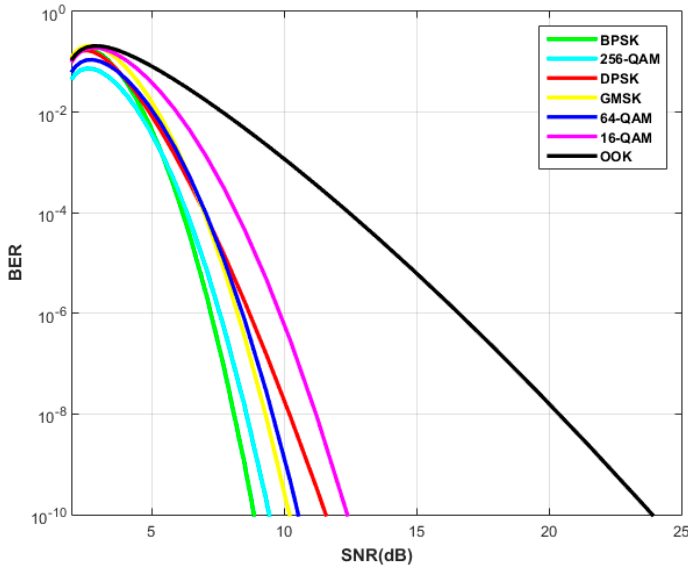
Figure 4. Bit error rate (BER) performance of different modulation formats without space diversity reception technique (SDRT) in a weak turbulence channel.